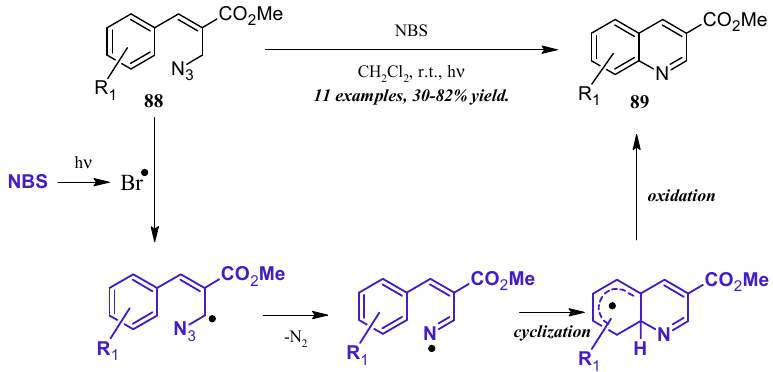
Figure 38. NBS-mediated radical cyclization to form 3-substituted quinolines.